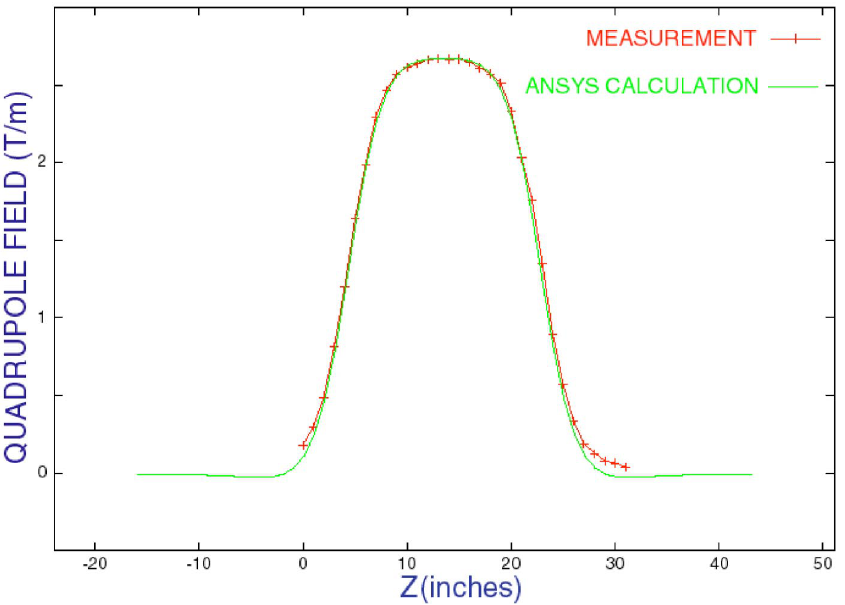
FIG. 23. (Color) Calculated and measured NTX quadrupole